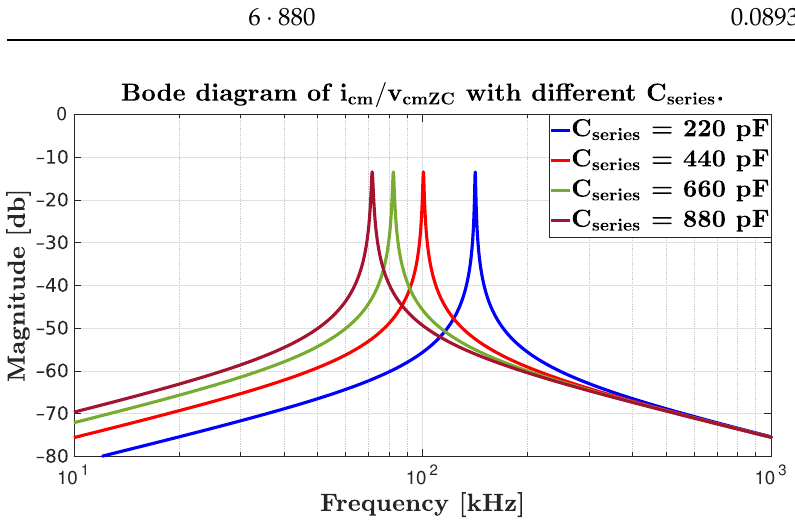
Figure 18. Bode Diagram of i cm ( s ) / v cmZC ( s ) during Zero Vector application with different values of C series